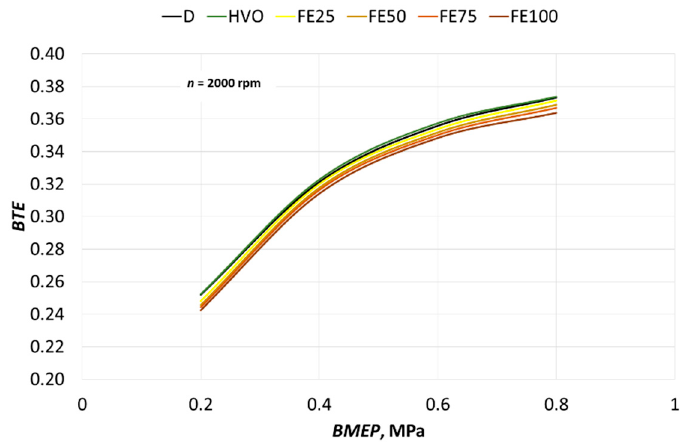
Figure 8. Dependence of BTE on the load.